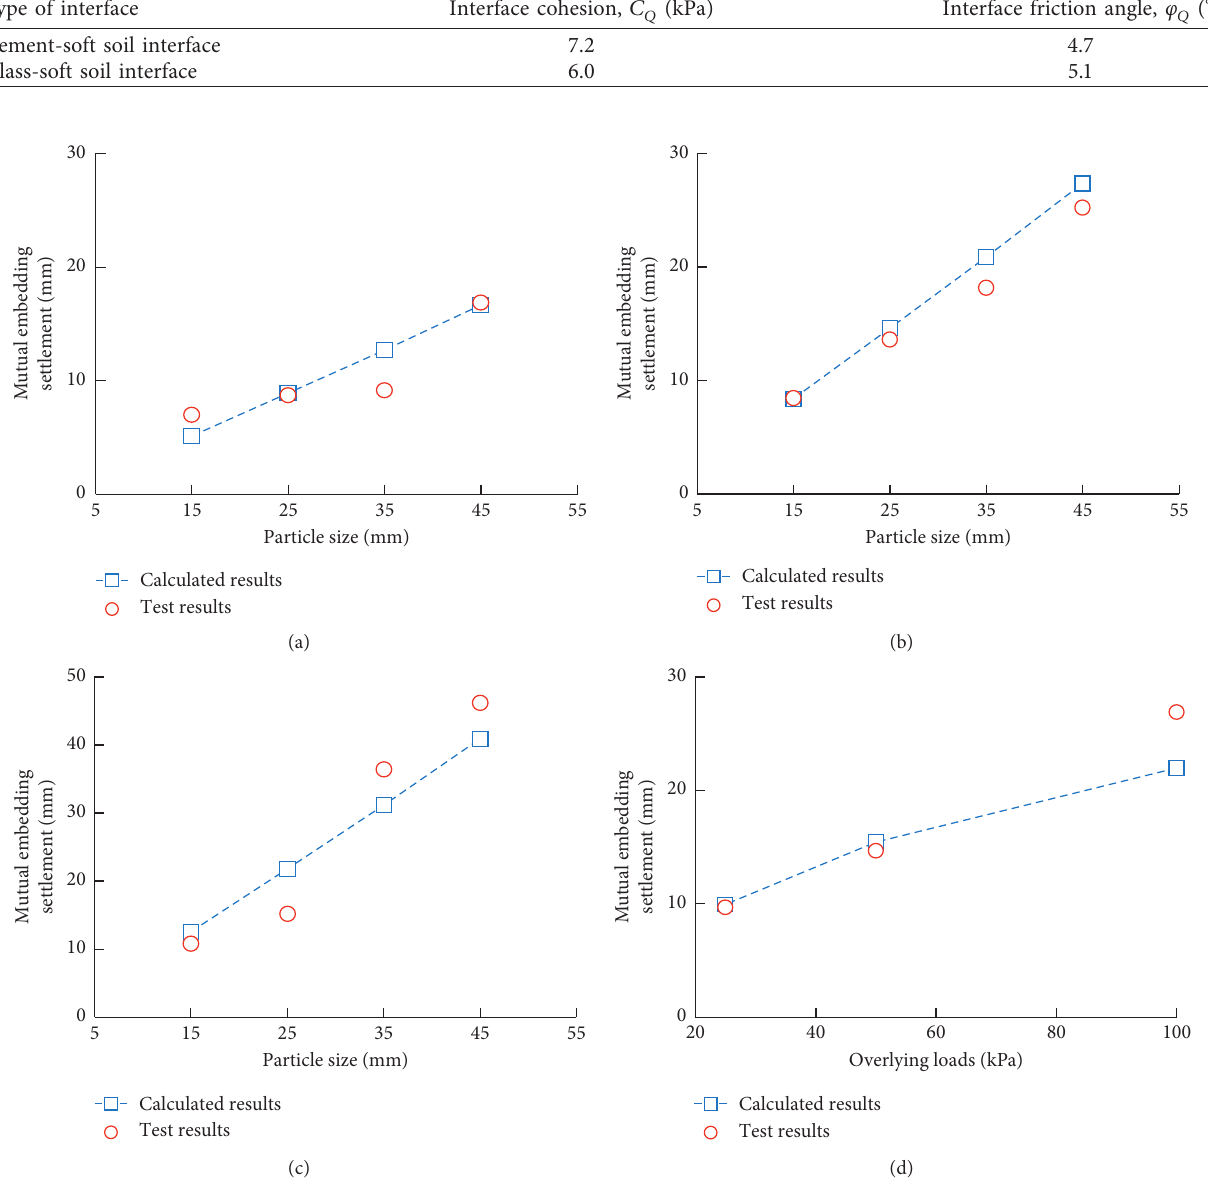
Figure 12: Comparison of calculated values with test results of mutual embedding settlement: (a) with 25kPa external loading; (b) with 50kPa external loading; (c) with 100kPa external loading; (d) the sample with 25mm glass